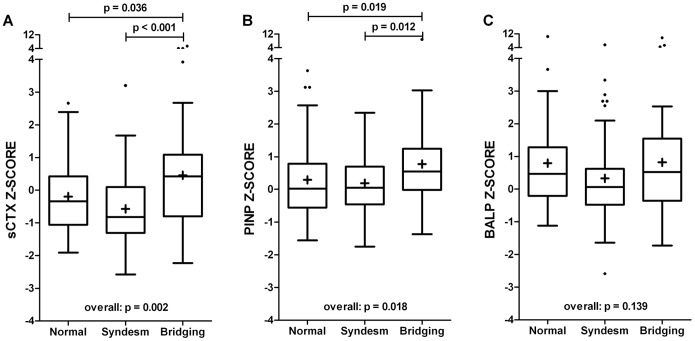
Bone turnover in AS patients with ≥1 complete bridge (n = 52), ≥1 non-bridging syndesmophyte (n = 49), and without syndesmophytes (n = 50).A) bone resorption marker sCTX, B) bone formation marker PINP, C) bone formation marker BALP. Box-and-whisker plots (Tukey): boxes indicate medians with interquartile ranges;+indicate means; whiskers indicate 1.5 times the interquartile distances; · indicate outliers.